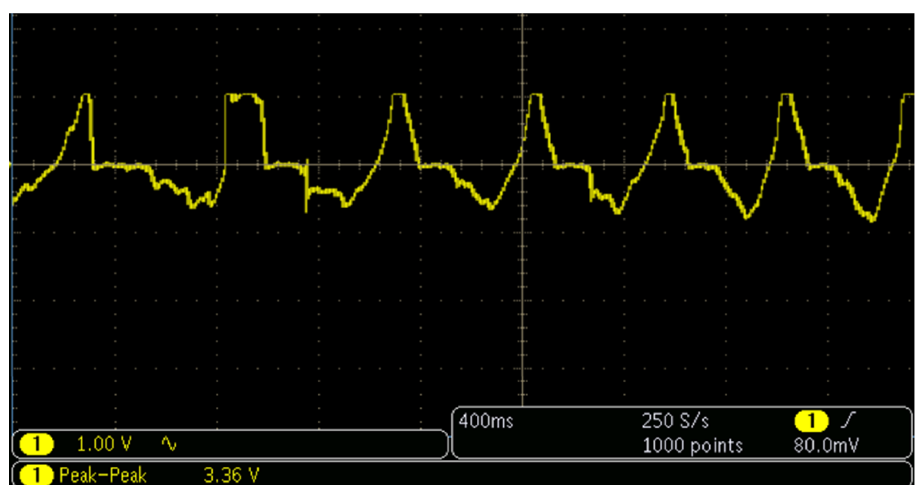
Figure 5. Output voltage under operating condition.